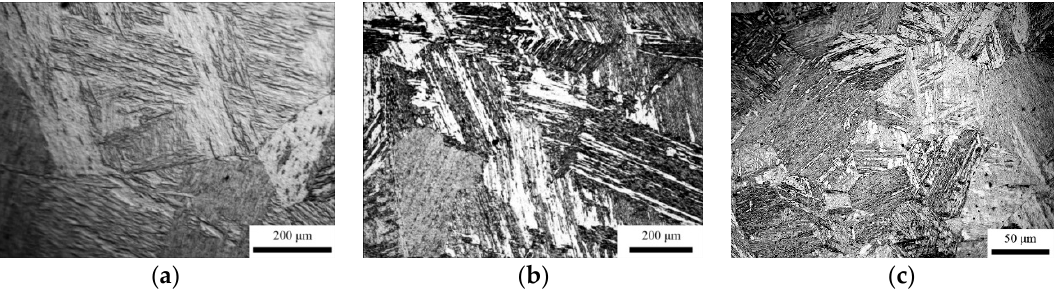
Figure 6. Quenching metallographic microstructure. ( a ) 4# sample, reheating to 1100 °C; ( b ) 5# sample, reheating to 1100 °C and cooling to 800 °C with 1 °C/s; and ( c ) 6# sample, reheating to 1000 °C and cooling to 800 °C with 1 °C/s.